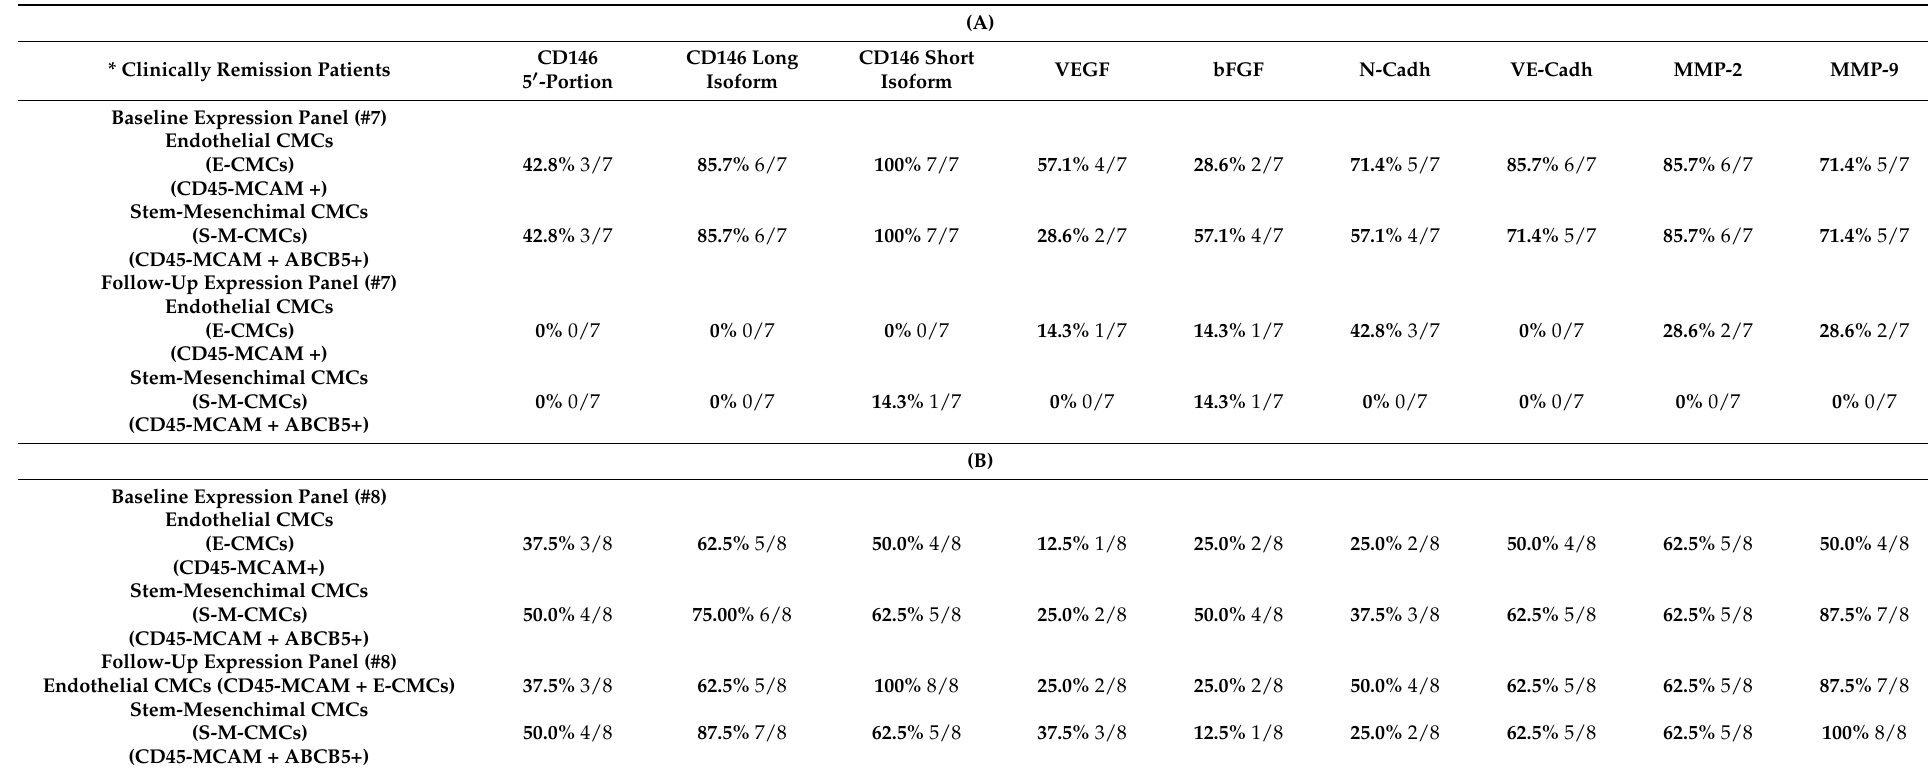
Table 4. Molecular expression (percentage) of proangiogenic markers, cell–cell adhesion factors, and matrix metallo-proteinases in the two enriched CMC subpopulations from the melanoma patients in clinical remission status, (Part A) and melanoma patients in stable or disease progression clinical status, (Part B). Because two patients* (UPN1-AV and UPN2-MU) with a longer follow-up after a period of clinical remission developed disease progression, the study included and analyzed both the two follow-up conditions. Consequently, despite the case series consisting of 13 patients, it is reported here the sequential molecular expression of 15 follow-up blood